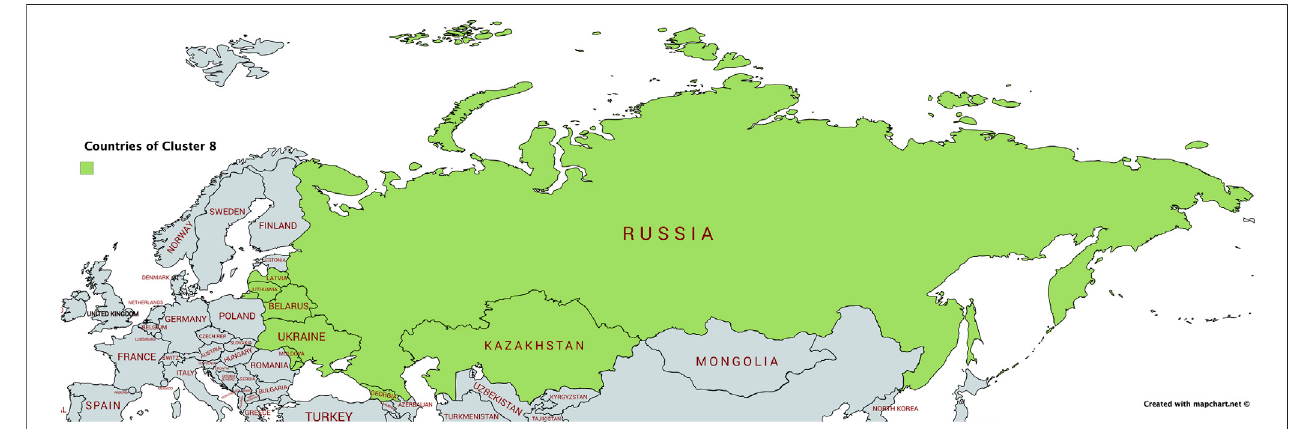
FIGURE 13 | Countries in Cluster 8 on a